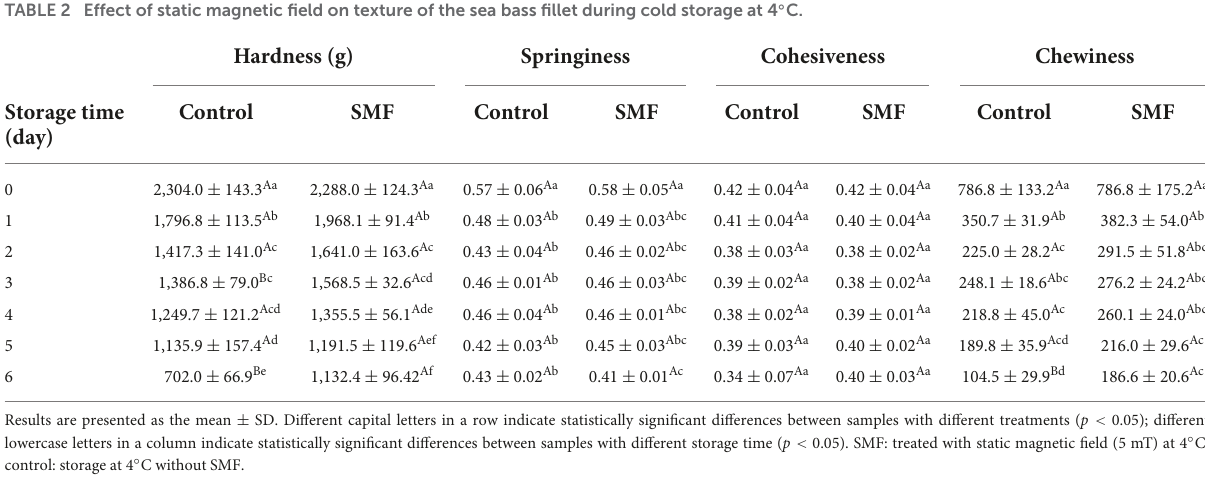
TABLE 2 Effect of static magnetic field on texture of the sea bass fillet during cold storage at 4 ◦